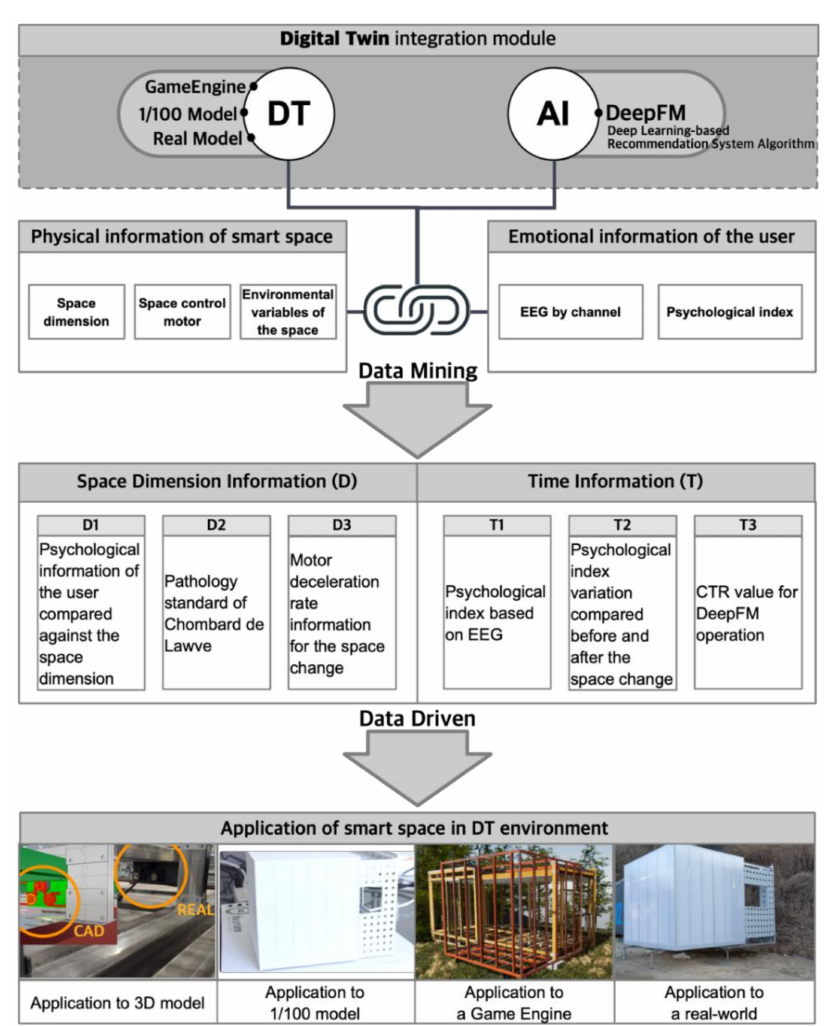
Figure 7. Composition of deep learning agent for smart space